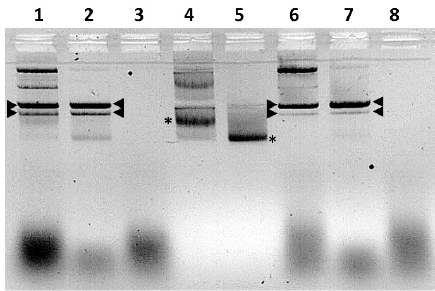
Figure 18. Electrophoretic mobility shift assays after interaction with GST-fused NS5 of KEMV or BTV-8. Protein-DNA binding reactions were performed in 0.5 × TBE buffer containing 100 mM NaCl and 5 mM MgCl 2 for 30 min at room temperature. The reaction products were analysed by electrophoresis in 1% agarose gel containing TBE 0.5 × and 100 mM NaCl. Lane 1: pCIneo plasmid (100 ng) plus 100 ng of KEMV GST-fused NS5; lane 2: pCIneo-24CG plasmid (100 ng) plus 100 ng of KEMV GST-fused NS5; lane 3: GST-Fused NS5 of KEMV; lane 4: pCIneo plasmid (100 ng); lane 5: pCIneo-24CG plasmid (100 ng); lane 6: pCIneo plasmid (100 ng) plus 100 ng of BTV-8 GST-fused NS5; lane 7: pCIneo-24CG plasmid (100 ng) plus 100 ng of BTV-8 GST-fused NS5; lane 8: GST-fused NS5 of BTV-8. Nucleic acids were visualised after electrophoresis by UV transillumination in the presence of ethidium bromide. Supercoiled forms of the pCIneo or pCIneo-24CG are indicated by asterisks. Plasmid-NS5 complexes are indicated by arrow heads.